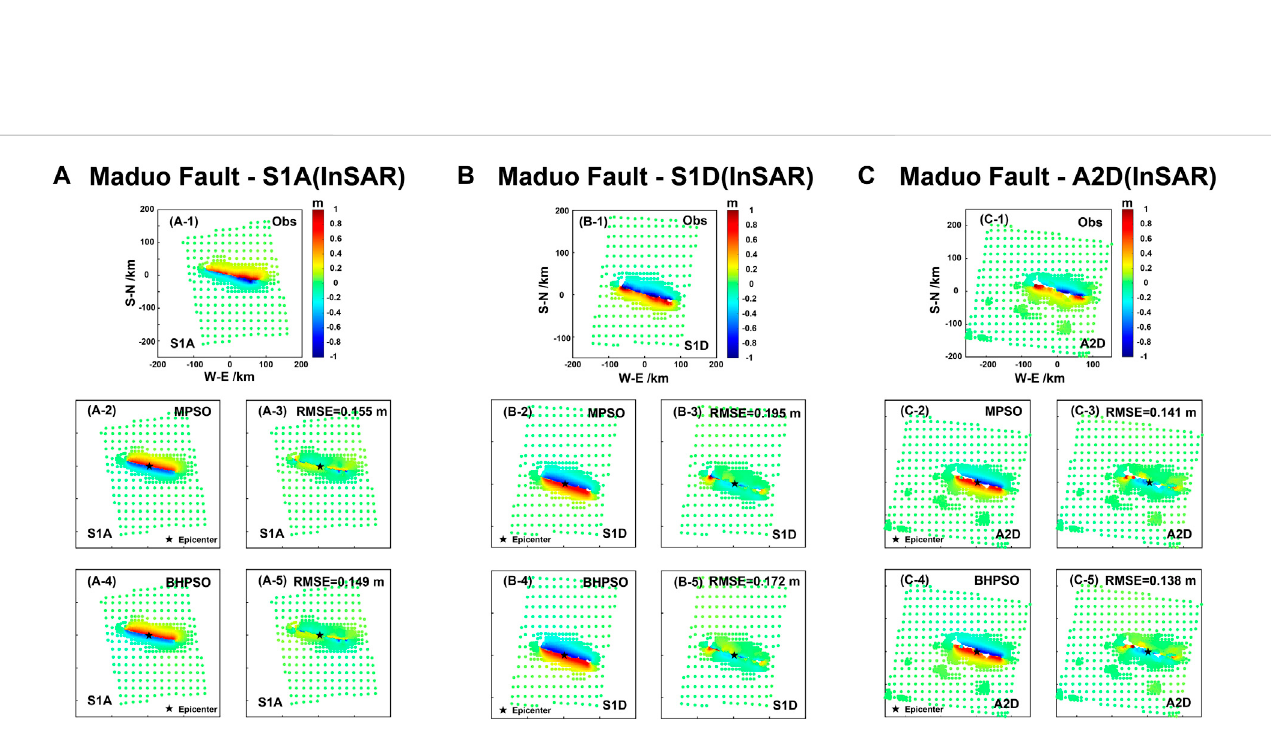
The comparisons of surface horizontal deformation (InSAR data) of the observed and the Okada model results by using fault parameters given by the inversed from MPSO and BHPSO methods in Table 7. (A) The Sentinel-1 ascending data and the inversion results from MPSO and BHPSO. (B) The Sentinel-1 descending data and the inversion results from MPSO and BHPSO. (C) The Sentinel-2 descending data and the inversion results from MPSO and BHPSO.